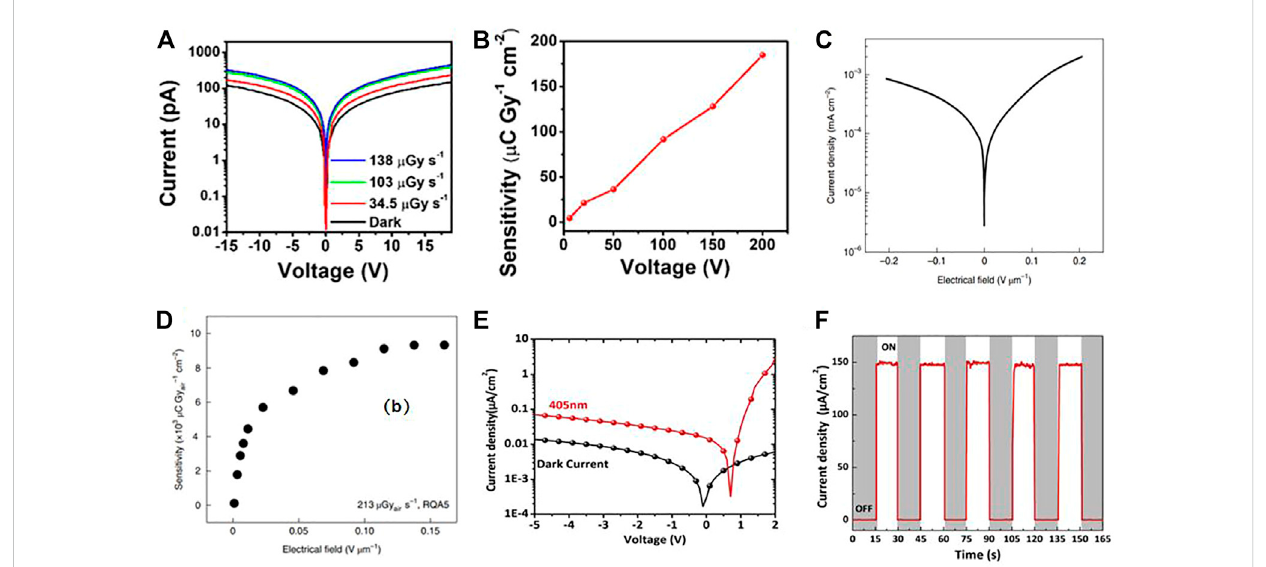
FIGURE 7 PhotoelectricpropertiesofperovskiteX-raydetectors. (A) Dark(black)andresponse current − voltage(J − V) curvesofthe(PEA) 4 AgInBr 8 SCsdetector at dose rates of 34.5, 103, and 138 μ Gyair s − 1 . (B) Dependence of X-ray sensitivity on applied voltage based on (PEA) 4 AgInBr 8 SCs detector. (C) Current density measurement under dark condition for an MAPbI 3 wafer. The applied voltage ranges from − 200 to +200 V, which corresponds to an electrical fi eld of ±0.2 V μ m -1 . (D) Calculated sensitivity (S) of the X-ray responses in the RQA5 spectrum and a dose of 213µGyairs − 1 . Optical response: (E) Current-voltage(IeV)curveofthedevicesunderdarkatmosphereandawavelengthof405 nmlaser. (F) Photoresponseofthedeviceunder405 nmlaser with the power density of 0.636 mW/cm 2 at zero bias voltage. ON is the device under the exposure of laser. OFF is the device under a dark atmosphere. Reproduced with permission from Ref. [46] (A) (B) , Ref. [50] (C) (D) , Ref. [49] (E) (F)